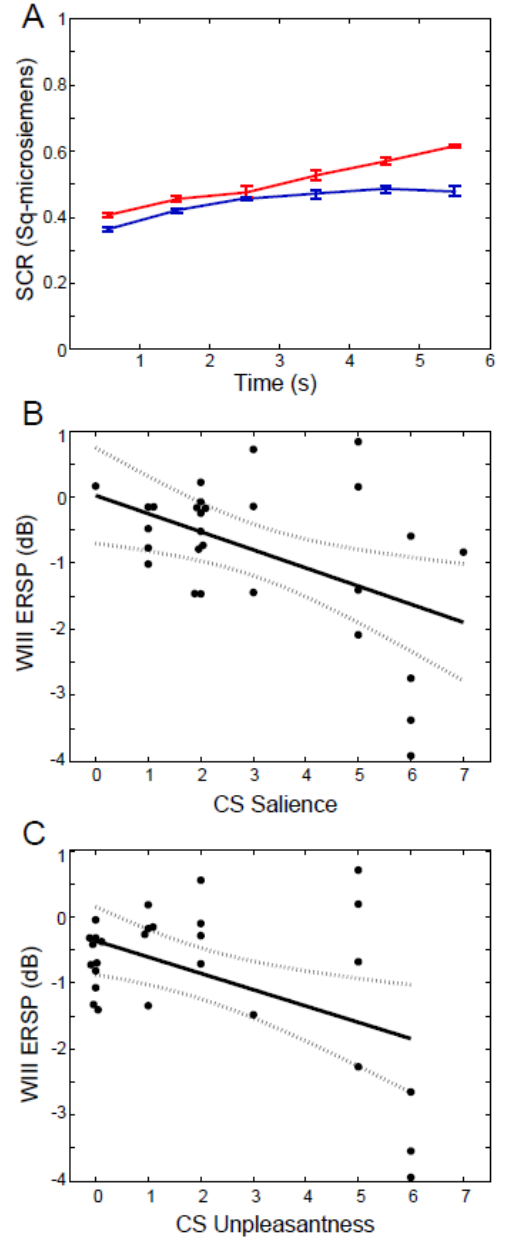
Figure 2. Skin conductance response (SCR) and CS Ratings during the Acquisition stage. ( A ) SCR ((mean +/- SEM)) at intervals after the CS+ (red line) and CS − (blue line). ( B , C ) are linear regression models (solid line) plus the 5% and 95% confidence bounds, dotted lines of WIII ERD vs. CS Salience and Valence across Subjects. See Text. Adapted from [12] .